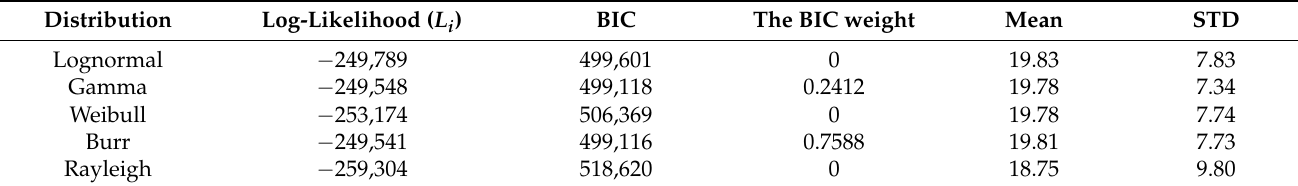
Table 2. Model selection for travel speed data on October 13 ( µ = 19.78, σ = 7.48